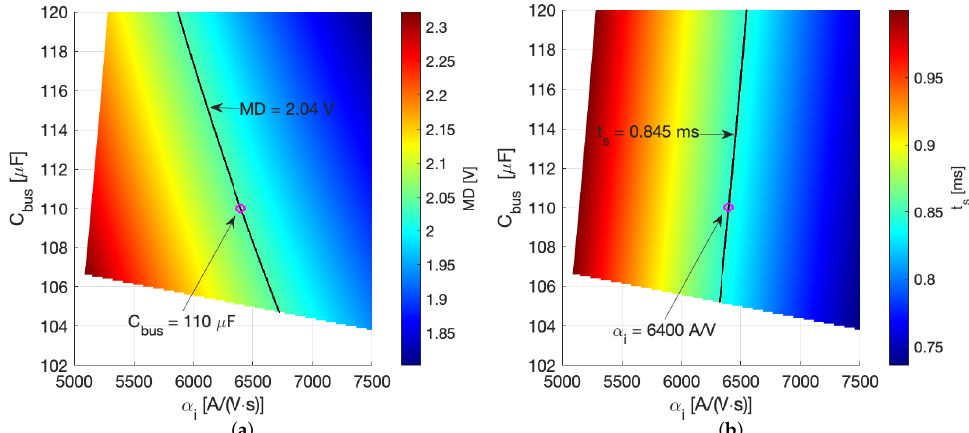
Figure 8. Plots used to design of C bus and α i . ( a ) Design of C bus in terms of MD . ( b ) Design of α i in terms of t s .